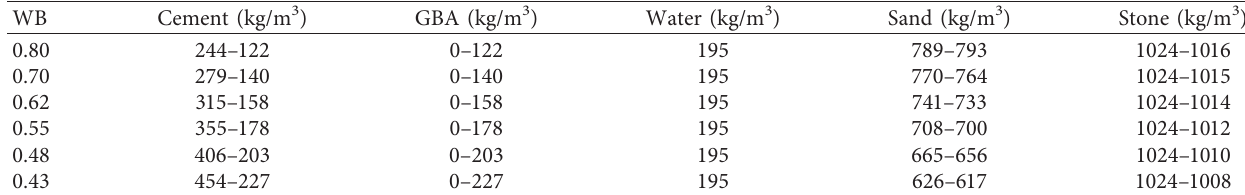
Table 3: Materials compositions for different mixes at 0–50% replacement with GBA.